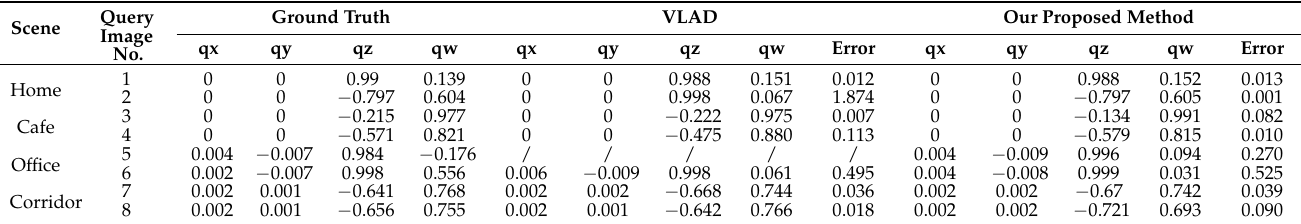
Table 2. Pose estimation result of VLAD and our proposed method (angle, quaternion